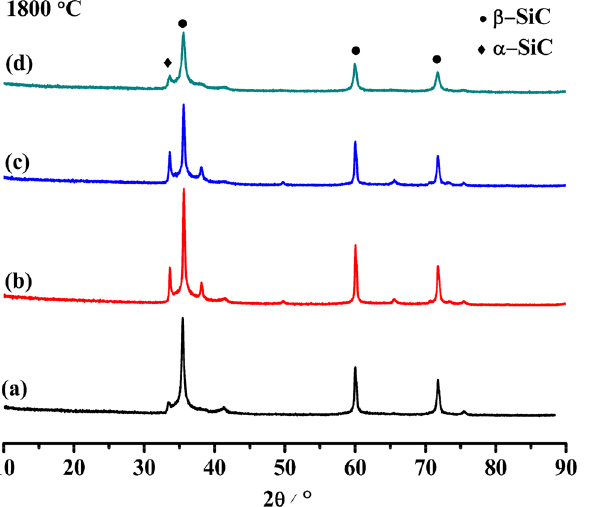
Figure 13: EDS elemental analysis of 1,600°C ceramics derived from ( a ) AHPCS and ( b ) PACS - 5.